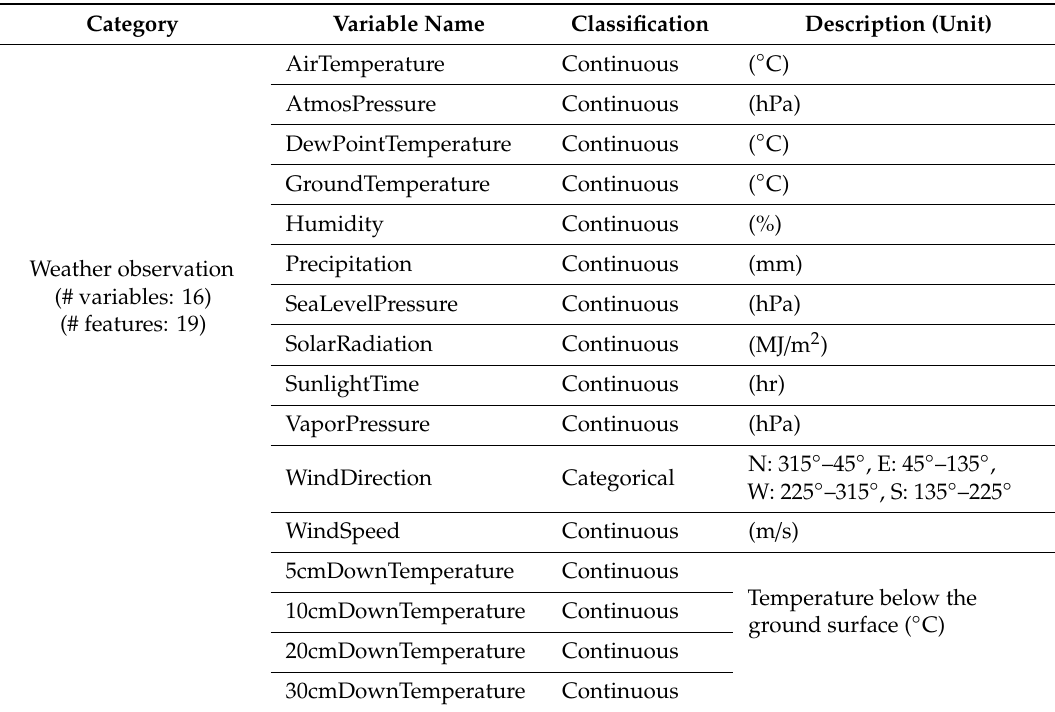
Table 2. Weather observation